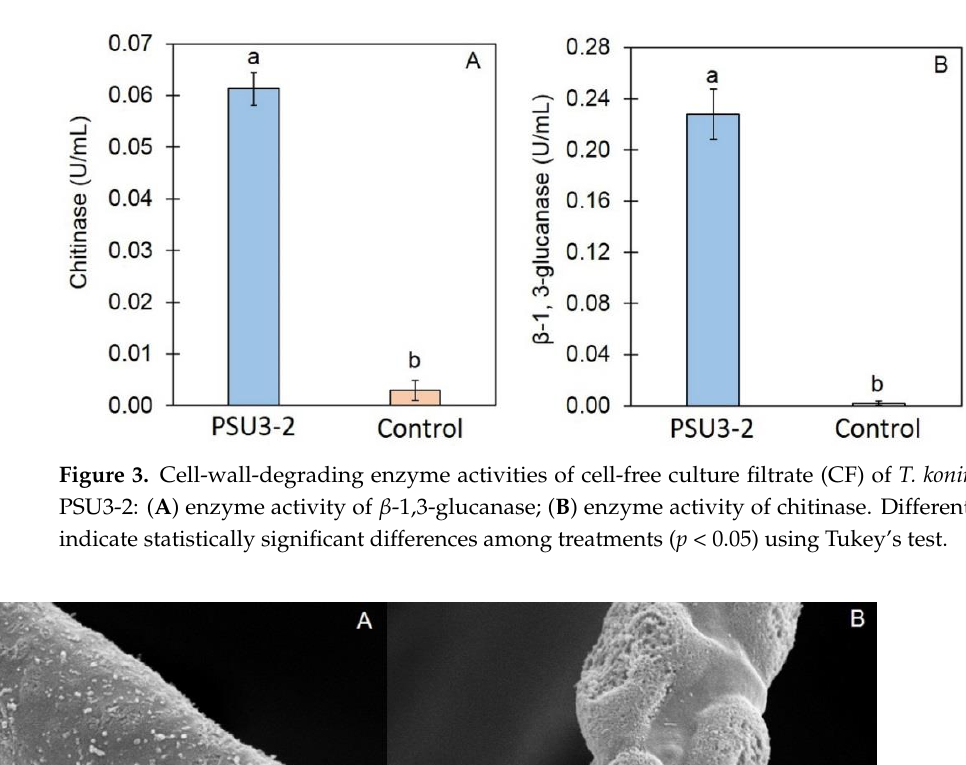
Figure 3. Cell-wall-degrading enzyme activities of cell - free culture filtrate (CF) of T. koningiopsis PSU3-2: ( A ) enzyme activity of β - 1,3 - glucanase; ( B ) enzyme activity of chitinase. Different letters indicate statistically significant differences among treatments ( p < 0 . 05 ) using Tukey’s test .